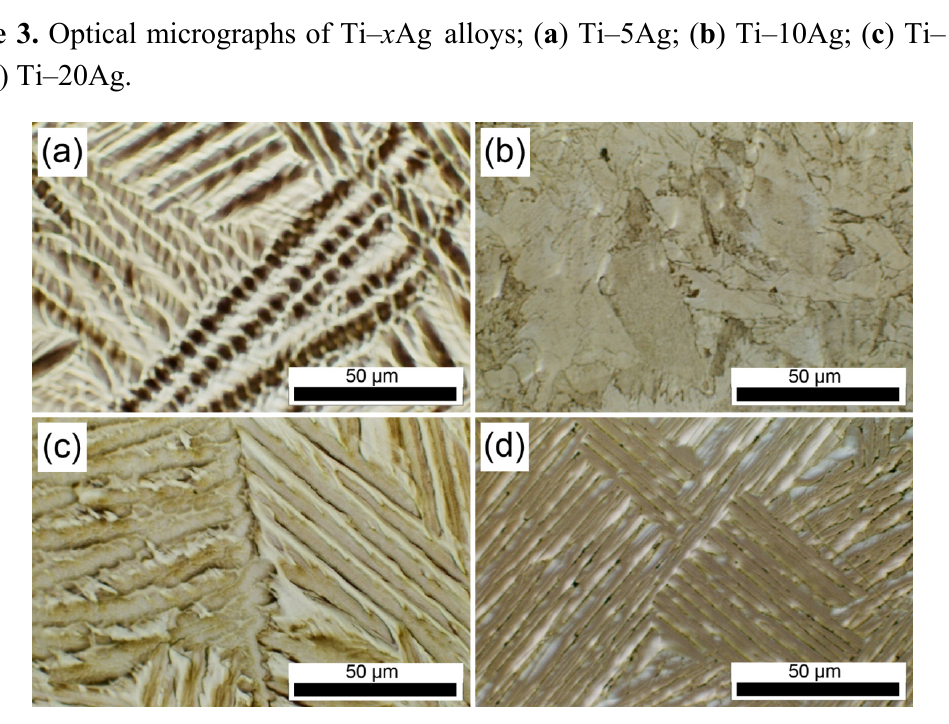
Figure 4. TEM micrographs of Ti– x Ag alloys; ( a ) Ti–5Ag; ( b ) Ti–10Ag; ( c ) Ti–15Ag; and ( d )